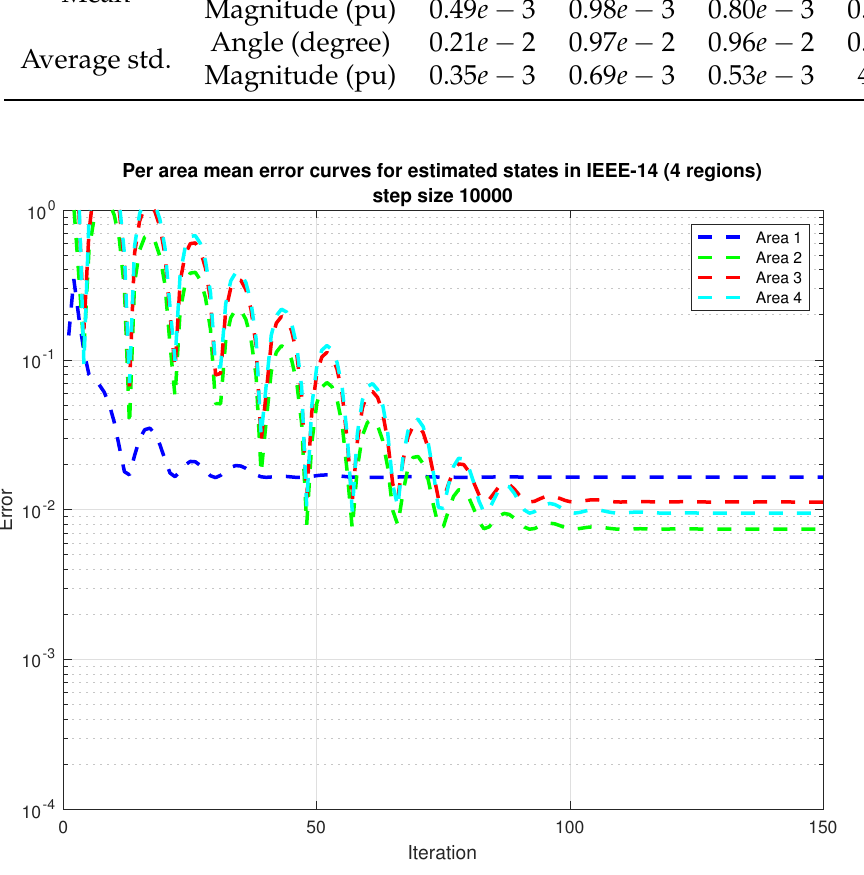
Figure 4. Per area error curves on the IEEE -14 bus system 4